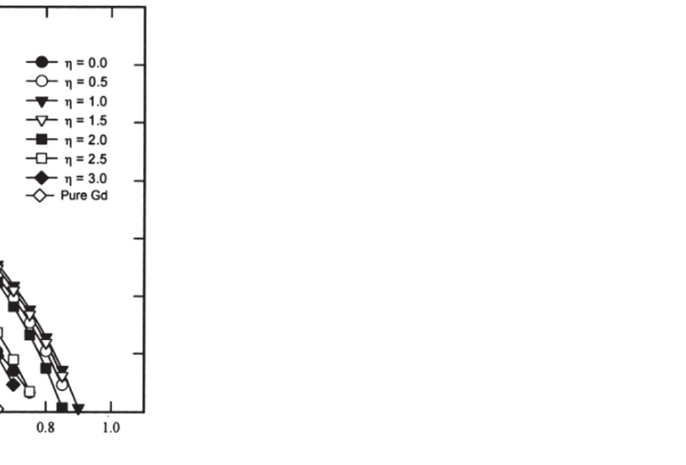
Figure 14. Temperature evolution of tow MCM versus hot temperature under a magnetic field of 2 T. Validation of the model reliability by comparison with experimental results [54]. Bouchekara et al. (2008) [56] developed a 1-D thermal semi-analytical model and a new method to design AMRR systems. The model is solved numerically by using FDM. An inverse approach has been considered to create the model. Indeed, the input used by the model is the performance of the chosen system (viz., cooling power, temperature pro- file, etc.). The outputs of the inverse problem optimization method are the geometry, the dimensions of the system, the physical properties, the flow rate, etc. The model presents a good accuracy (Figure 15). The results are relative to a system composed of Gd as MCM and water as heat transfer fluid for a magnetic field of 0.8 T. The authors proposed to do more studies with this more accurate and flexible method.